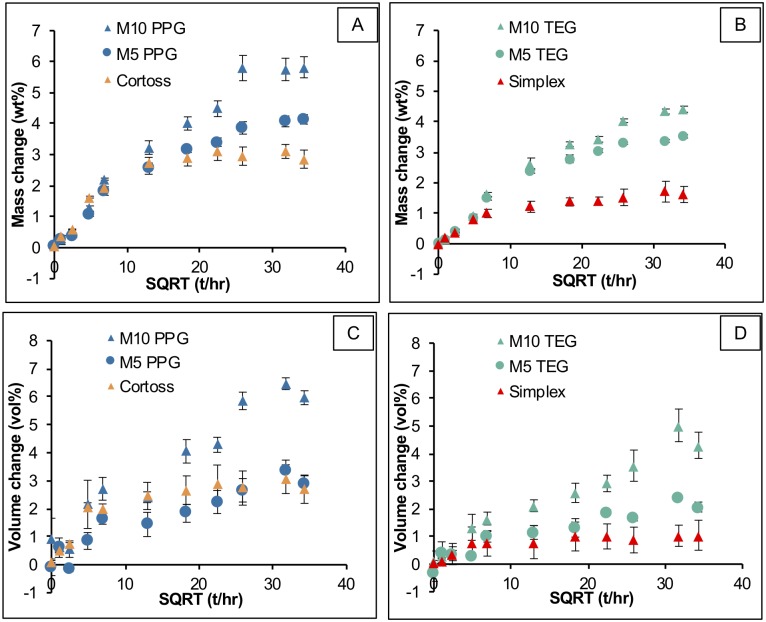
Mass and volume changes versus square root of time (hr) of all materials immersed in SBF for up to 6 weeks.Error bars are SD (n = 3).